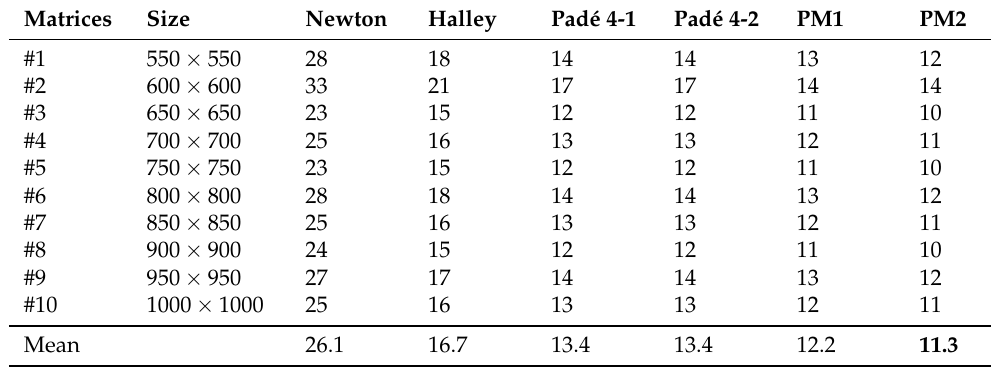
Table 3. Results of comparisons based on number of iterates for Experiment 2.